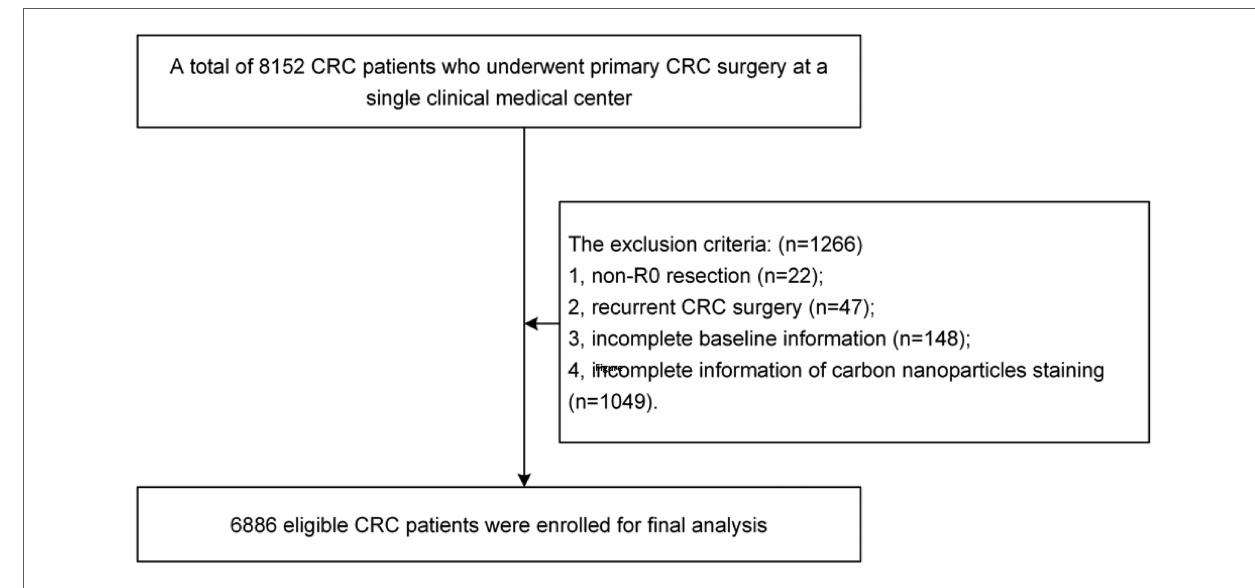
FIGURE 1 Flow chart of patient selection.Abbreviations: CNS, carbon nanoparticles